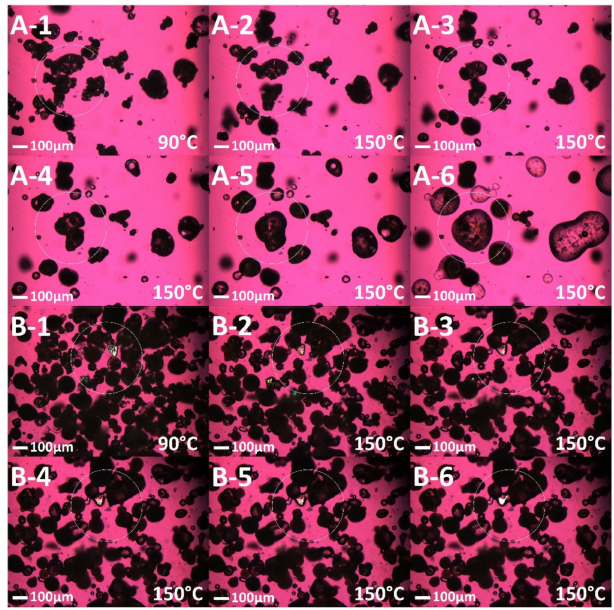
Figure 2. Hot stage microscopy images of PFS ( A-1 – A-6 ) and UFS ( B-1 – B-6 ) at different